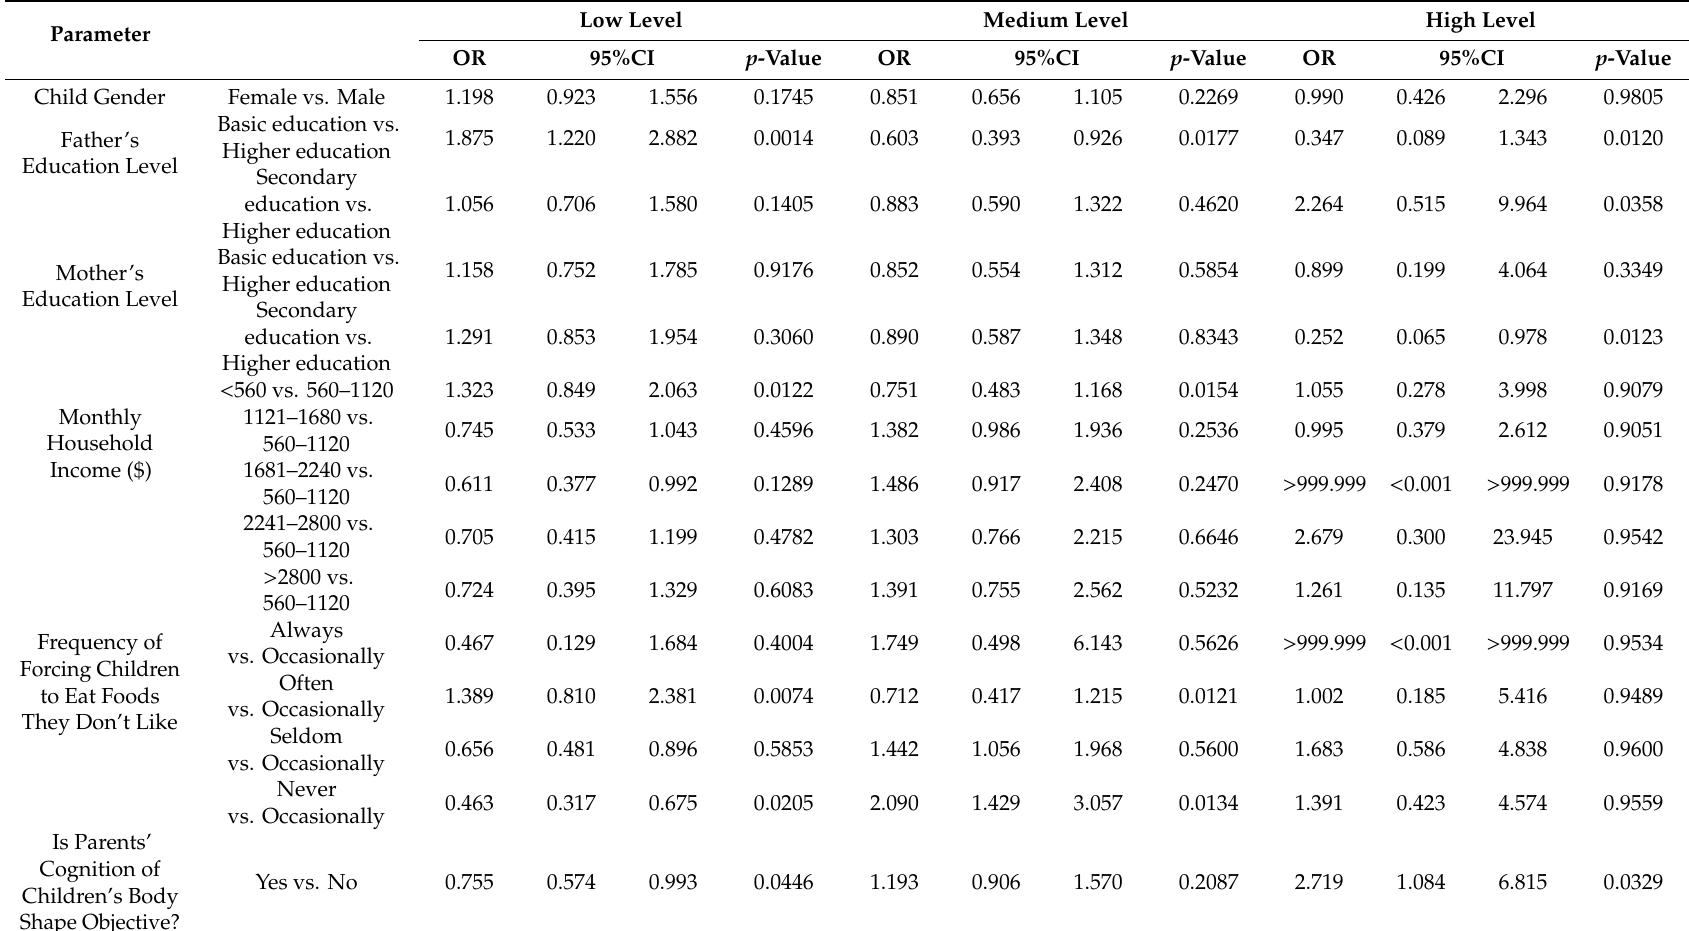
Table 4. Odds ratios (ORs) and 95% confidence intervals (CIs) for factors influencing di ff erent levels of eating